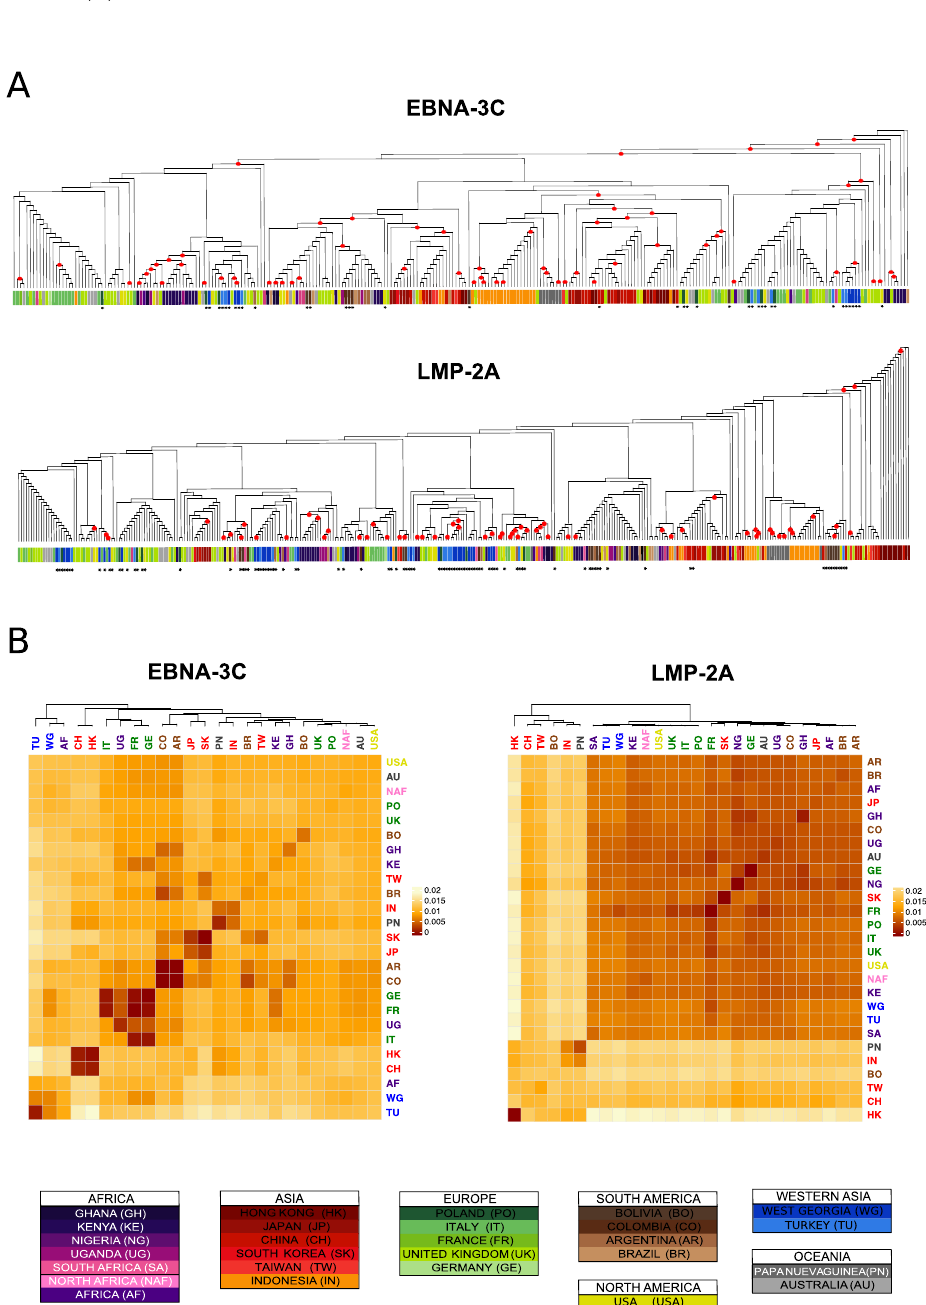
Figure 2. Di ff erence between genes phylogenies. Example of two genes with di ff erent genetic structure. ( A ) Cladograms of the maximum likelihood phylogenies are reported for two genes, with the leaves coloured per country of origin. The new sequences produced in this study are identified by black asterisks. Nodes with bootstraps values higher than 0.5 are indicated with a red circle. ( B ) Heatmaps representing the bootstrapped pairwise genetic distances between populations. The heatmap cells colour is proportional to the genetic distance value (the more similar the populations, the darker red the cell colour). Populations IDs correspond to the country of origin and are coloured by continent.